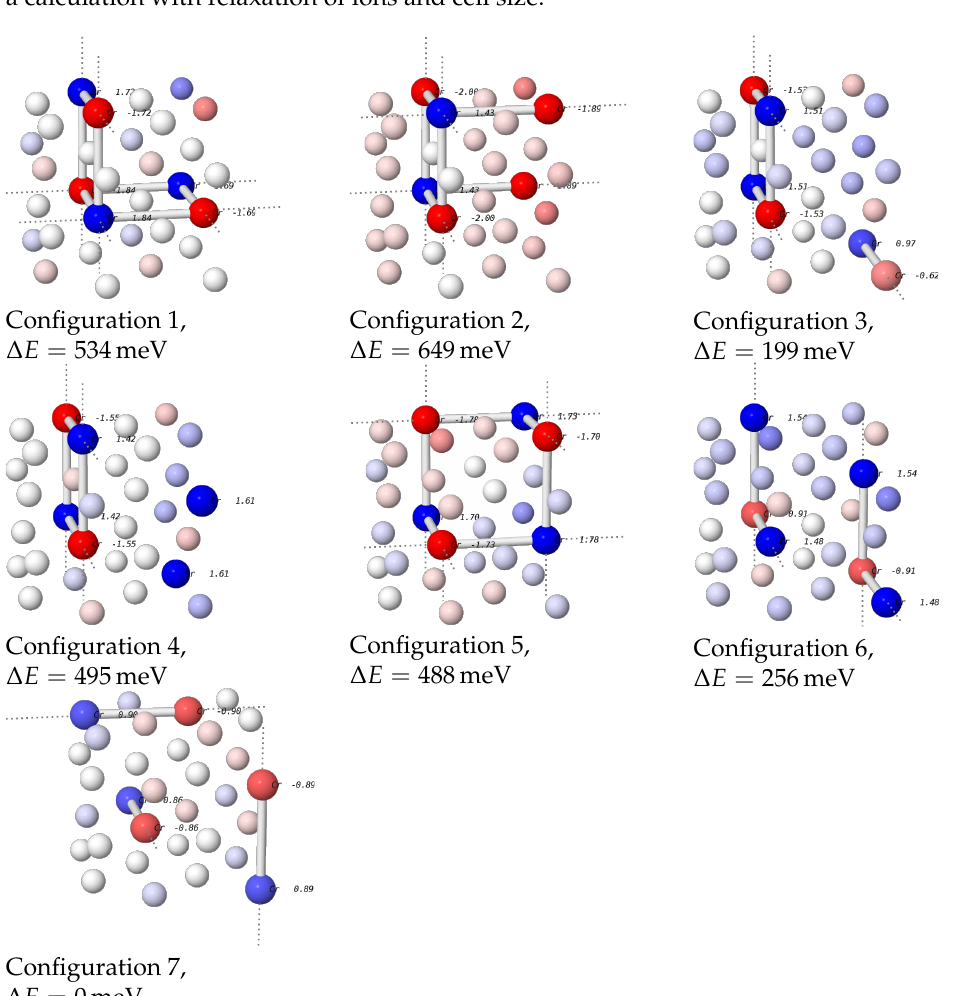
Figure 2. The seven possible Ni 26 Cr 6 supercells with no nearest-neighbor bonds between Cr atoms. Cr atoms are plotted with a larger radius. Next-nearest-neighbor bonds inside the cell are shown, periodic nearest-neighbor bonds are depicted as dashed lines. The color of the atoms encodes the magnetic moments in the final state. Magnetic moments for the Cr atoms are listed in the plots. For all configurations, energy differences relative to the lowest-energy configuration 7 are